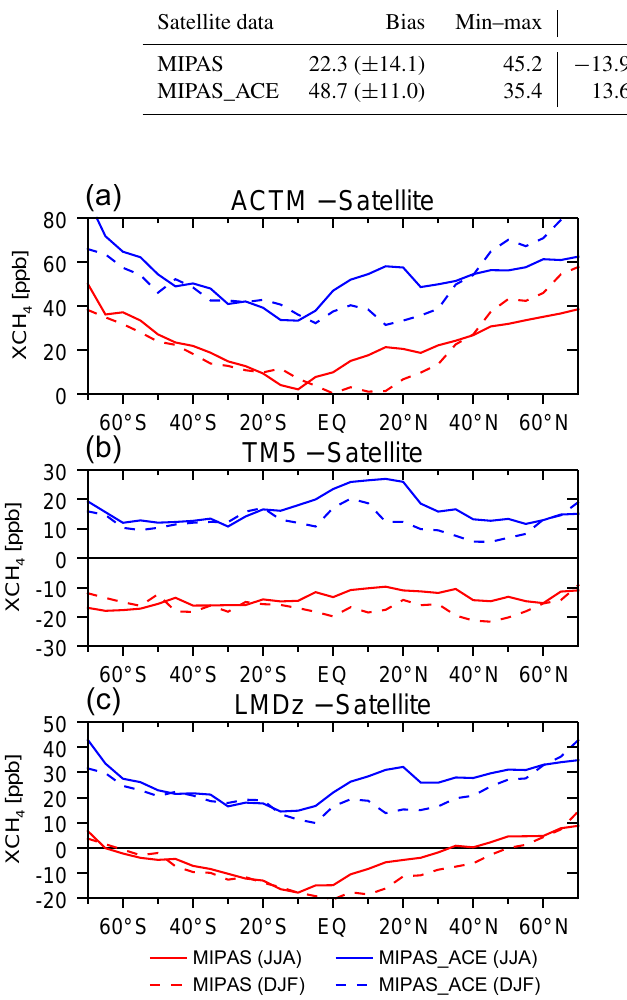
Figure 6. Zonal XCH 4 differences as a result of model–satellite differences of stratospheric CH 4 volume mixing ratios. Solid lines refer to the merged model–satellite CH 4 fields, including disconti- nuities at the model–satellite transition zone around the tropopause. Dashed lines refer to merged model–satellite CH 4 fields that have been smoothly interpolated at the model–satellite transition zone.